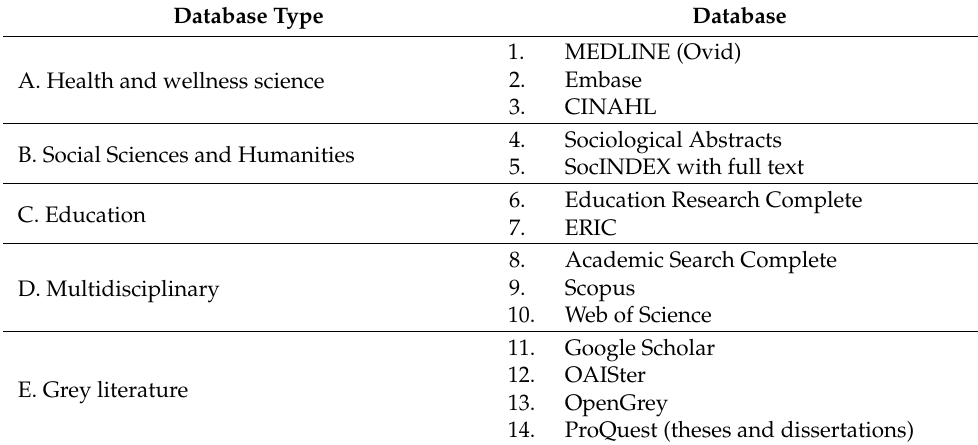
Figure 1. The steps of the integrative literature review. Table 1. Databases searched for